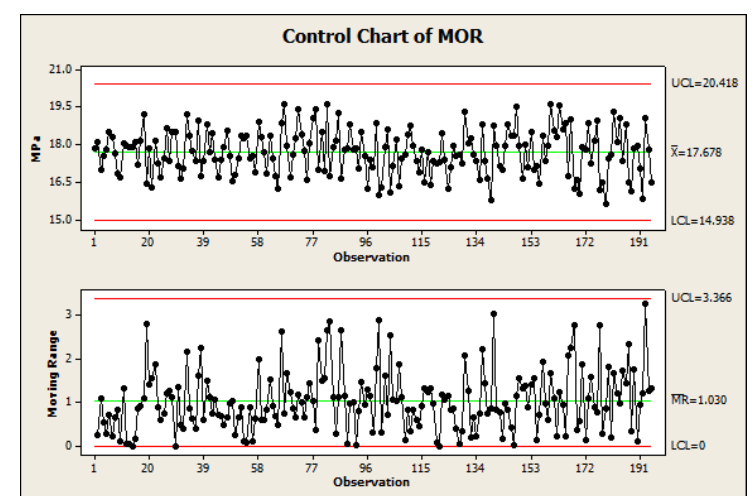
Fig. 7. I-MR control charts of